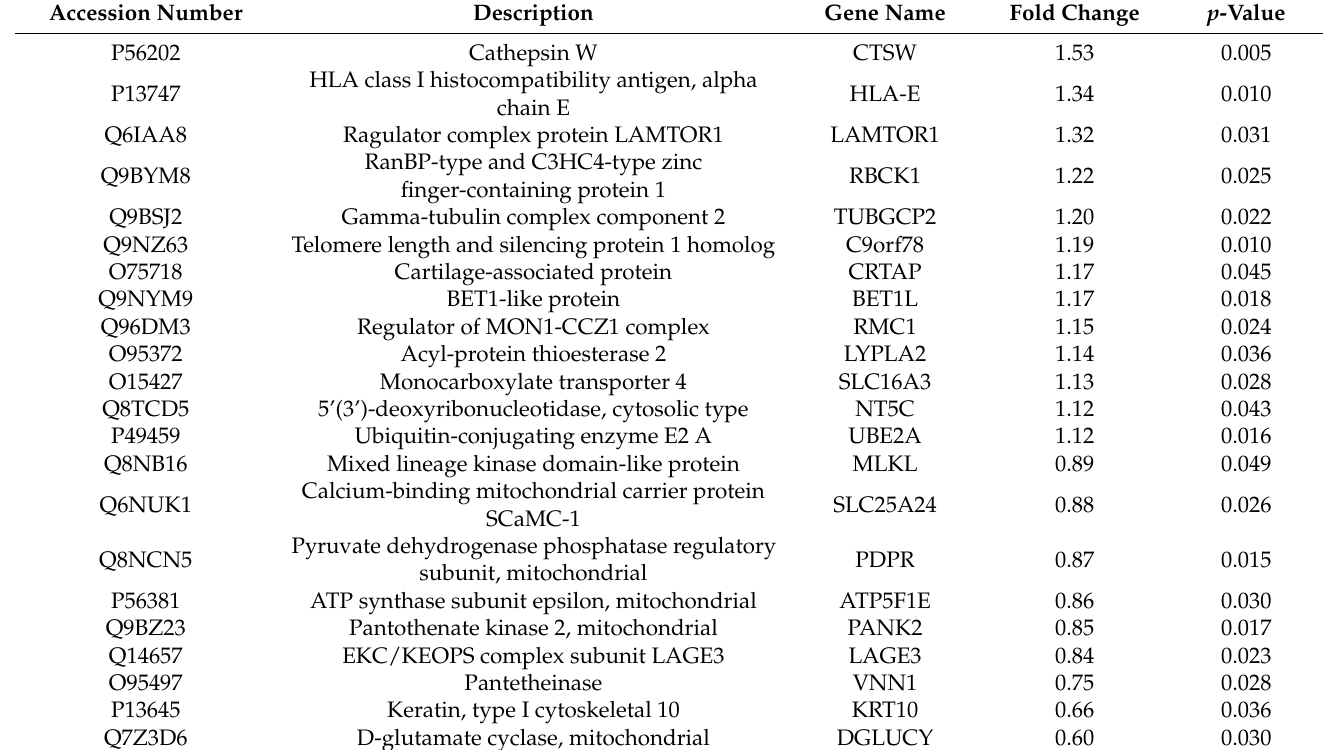
Table 3. Proteomic analysis with differentially altered proteins (DAPs) in the ME/CFS patients compared to the controls. Accession